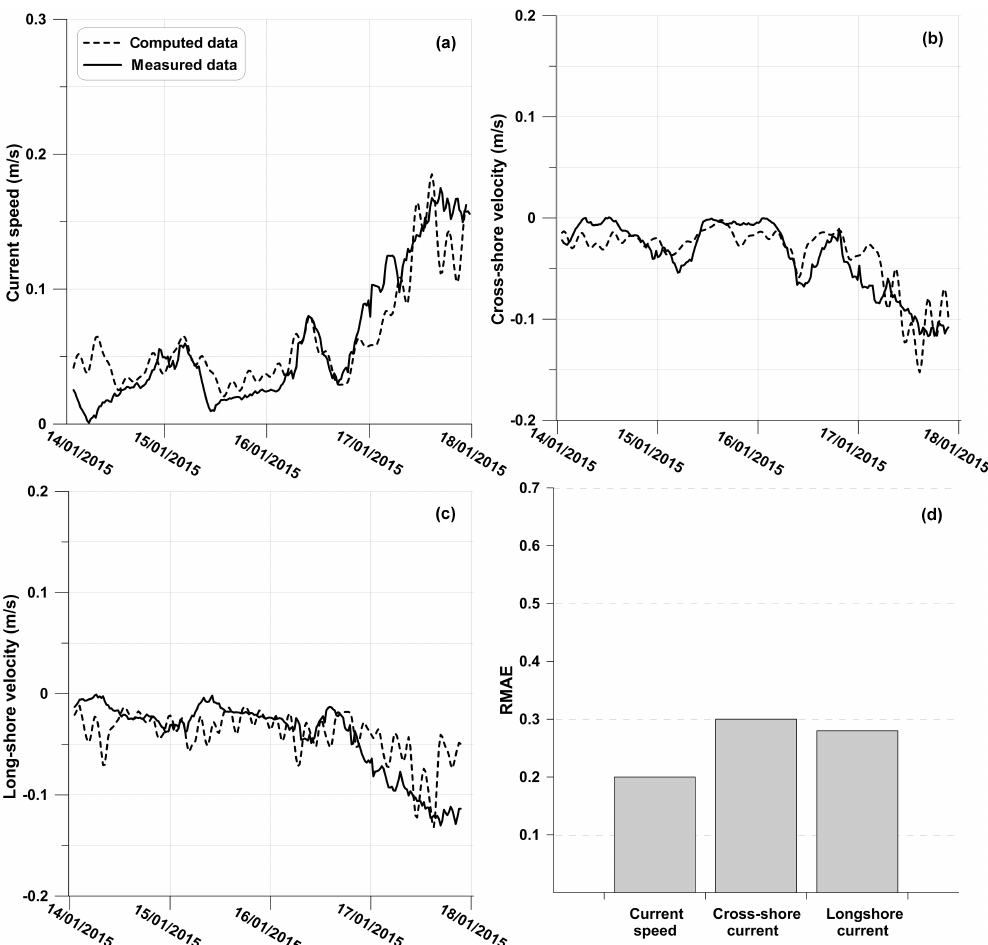
Figure 3. Validation of current-speed (a) , cross-shore (b) , and along-shore (c) components. The solid and dotted lines represent the measured and computed time series, respectively. Statistics (RMAE) for current-speed, cross-shore, and along-shore components are reported in (d)